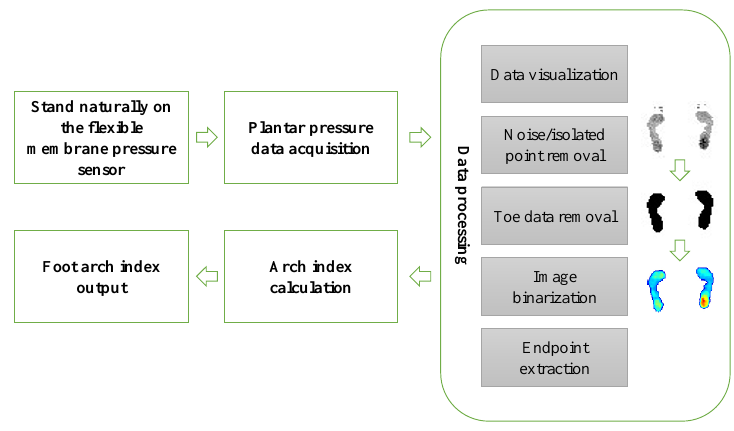
Figure 1. The framework of the proposed algorithm.